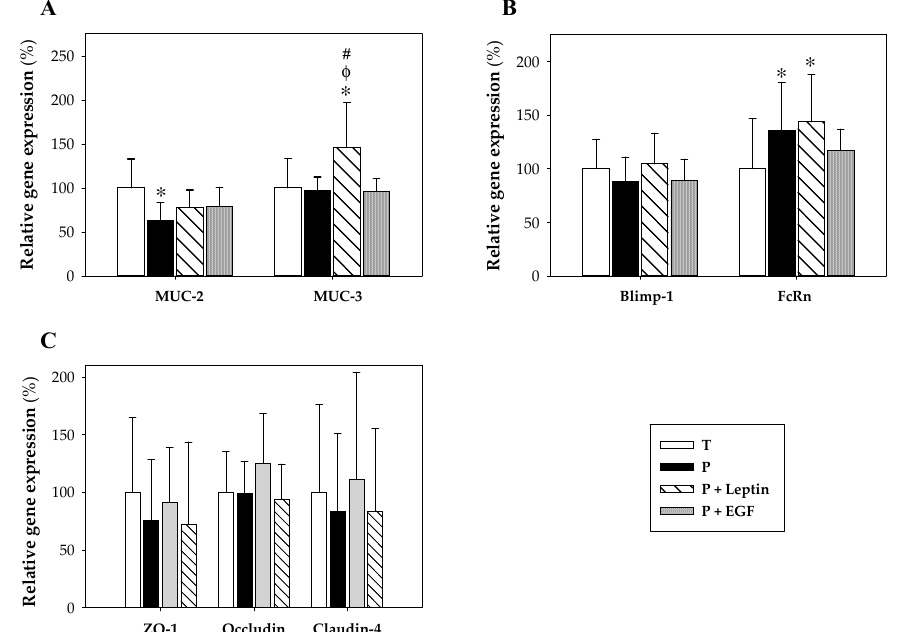
Figure 9. Gene expression in small intestine samples from the four groups: Term (T), Preterm (P), P+Leptin, and P+epidermal growth factor (P+EGF) at day 10 of the suckling period. MUC-2 and MUC-3 ( A ), Blimp-1 and FcRn ( B ), ZO-1 , occludin , and claudin-4 ( C ). Results are expressed as mean ± SD ( n = 9 pups/group). Statistical differences: * p < 0.05 versus T group; φ p < 0.05 versus P group; # p < 0.05 versus P+EGF group.